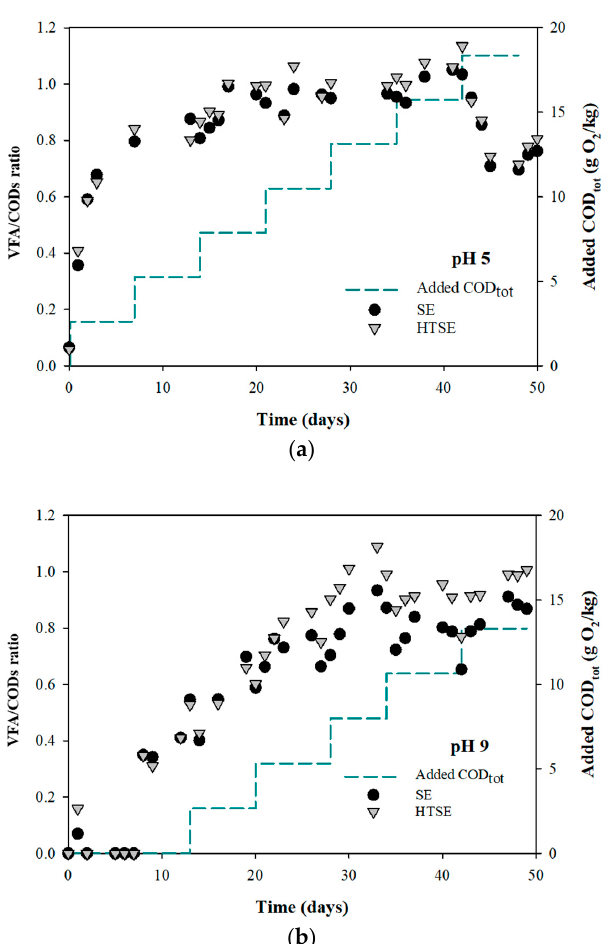
Figure 3. Relation from VFAs to COD s from SE and HTSE ( a ) at a pH of 5 and ( b ) at a pH of 9 with respect to feed.